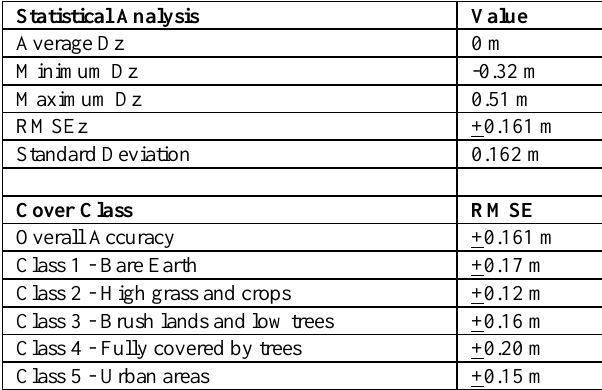
Using the 299 check points, the ground-classified points in the LiDAR data were evaluated in terms of elevation accuracy for the general categories of ground cover listed below.